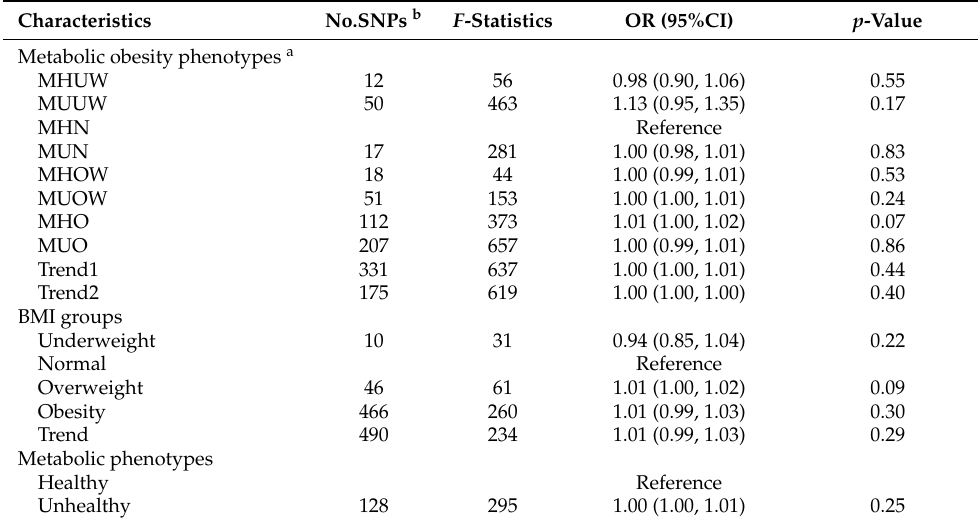
Table 2. One-sample MR estimates for the relationship between metabolic obesity phenotypes and incident LC.